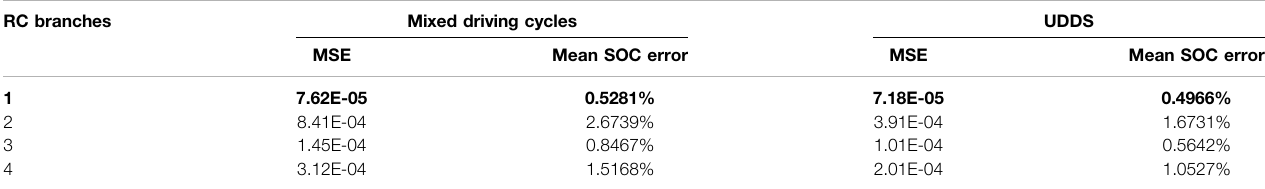
TABLE 22 | Augmented ECM-based H-in fi nity with 20% random bias.